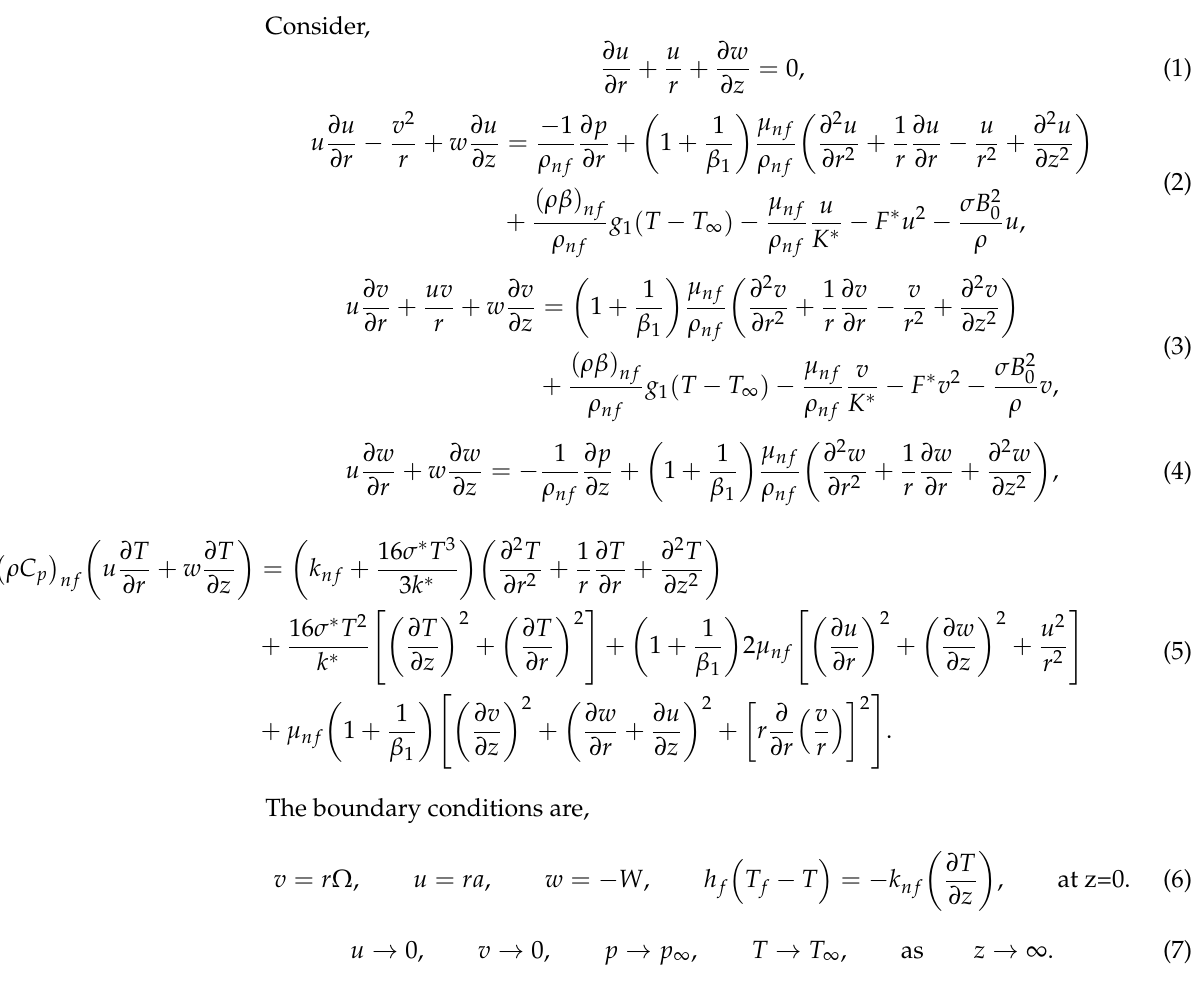
Figure 1. Physical model and coordinate